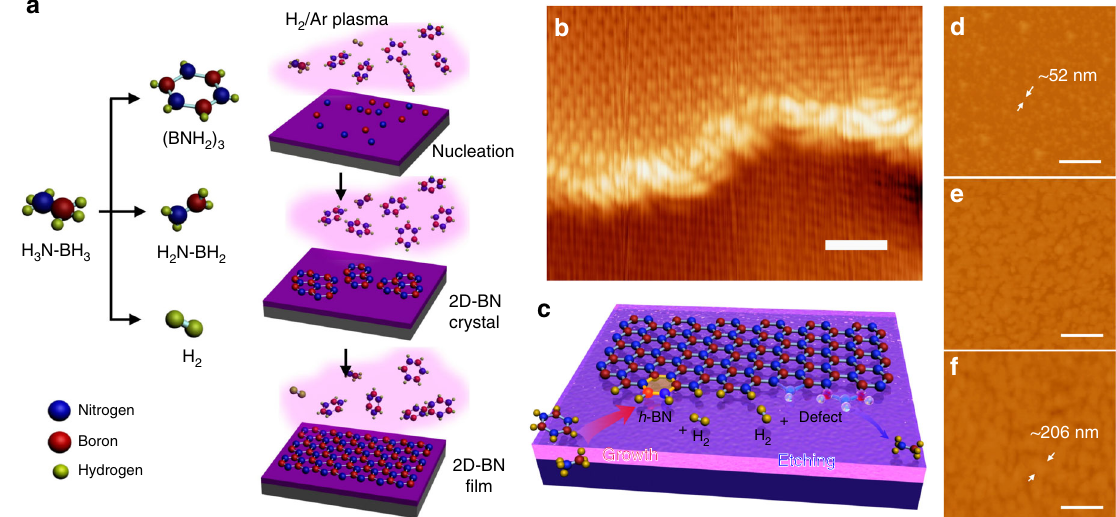
Fig. 3 Growth mechanism of near-equilibrium plasma-enhanced chemical vapor deposition (ne-PECVD). a Schematic illustration of the growth process of two-dimensional hexagonal-boron nitride (2D-BN) on SiO 2 /Si. b Scanning tunneling microscopy image of a 2D-BN edge ( V Tip = − 0.5 V). c Schematic illustration of the competition process of 2D-BN growth and etching in ne-PECVD. d – f Atomic force microscope images of the 2D-BN domains grown on SiO2/Si by ne-PECVD for d 8 min, e 15 min, and f 20 min. The scale bars are 1 nm in b and 500 nm in d –